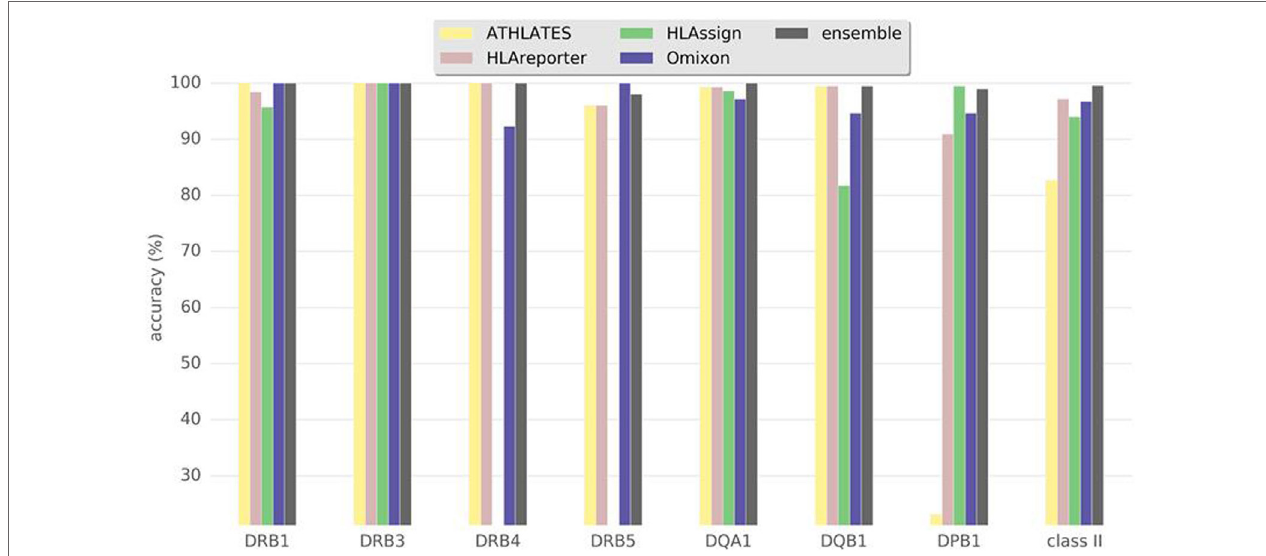
FigUre 2 | Accuracy of human leukocyte antigen (HLA) interpretation programs to type HLA class II alleles in the Finnish Red Cross Blood Service dataset comprising 93 Finnish individuals. Concordance rate to standard clinical HLA typing together with ensemble results are shown for each program package.